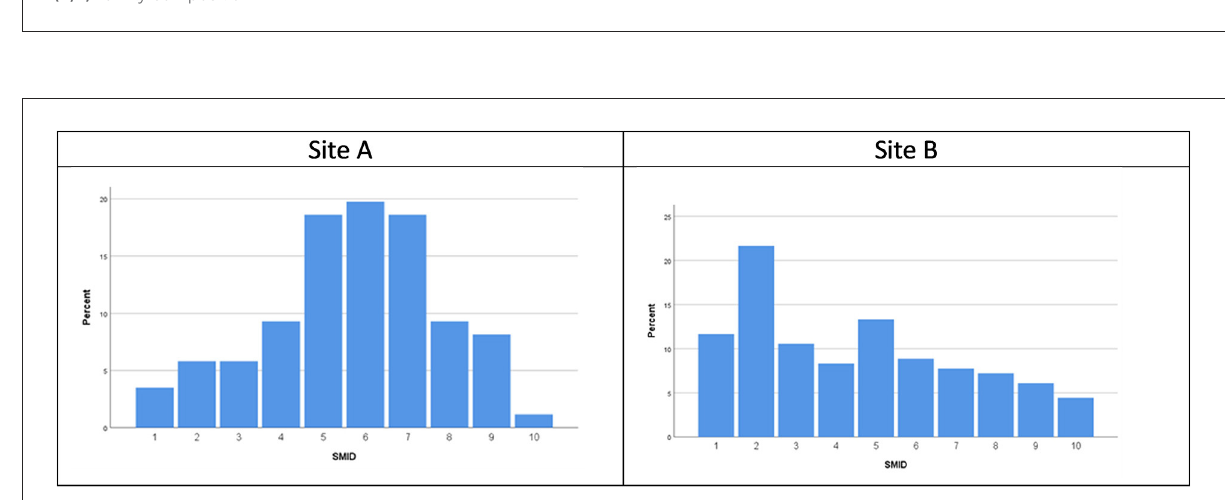
FIGURE3 (A,B) Scottish Index of Multiple Deprivation (SIMD 16)